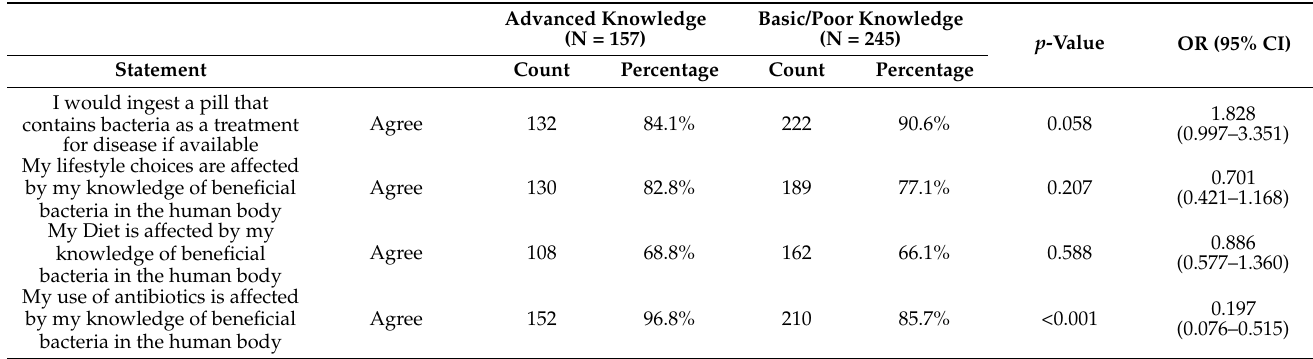
Table 5. Effect of microbiota knowledge on probiotic use and behavioral beliefs.